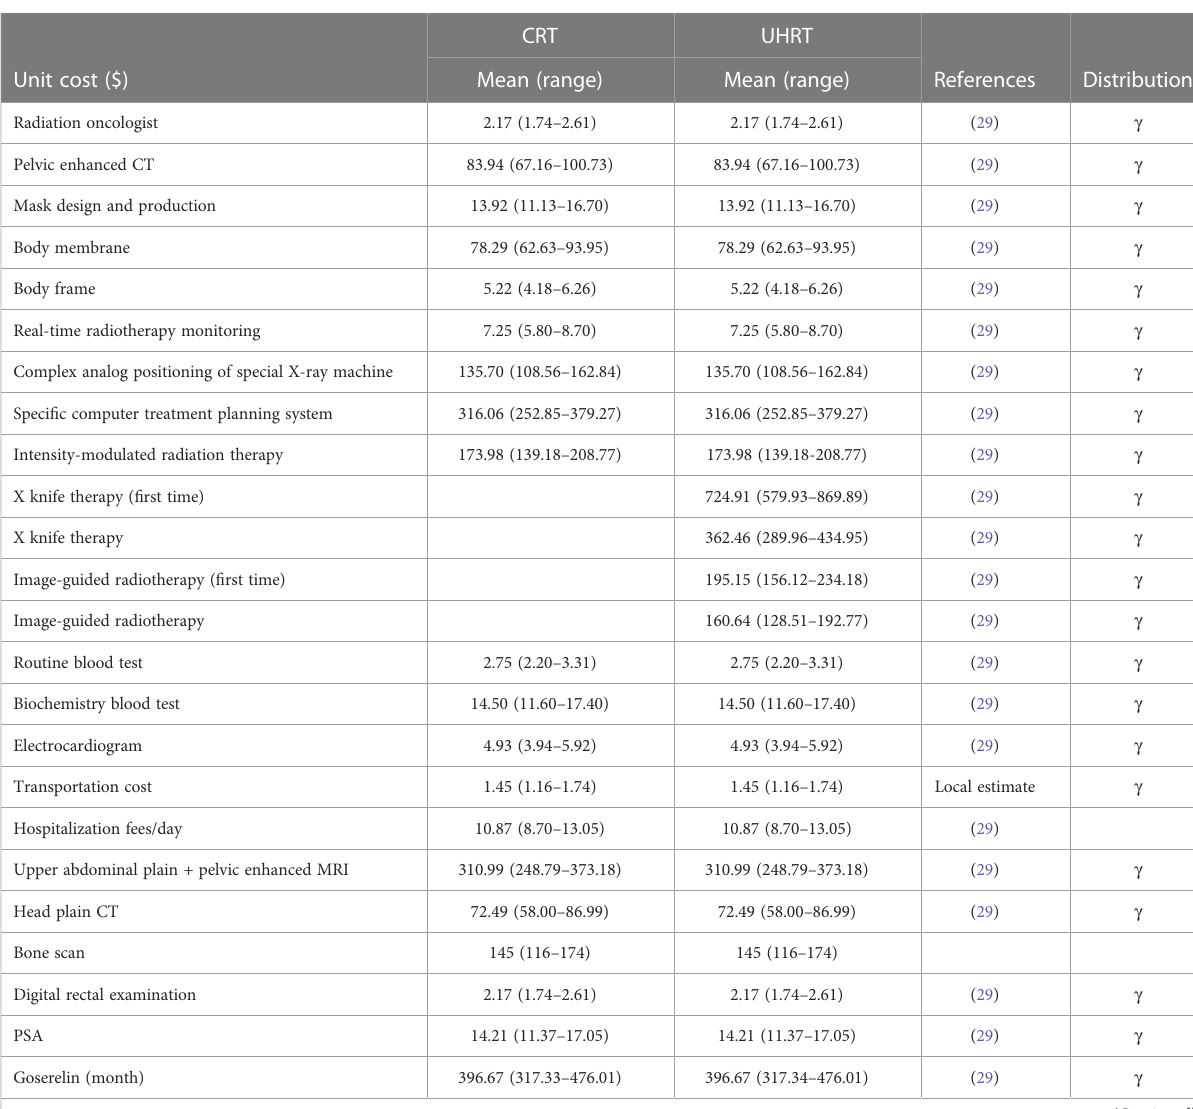
TABLE 3 Key cost parameters and related